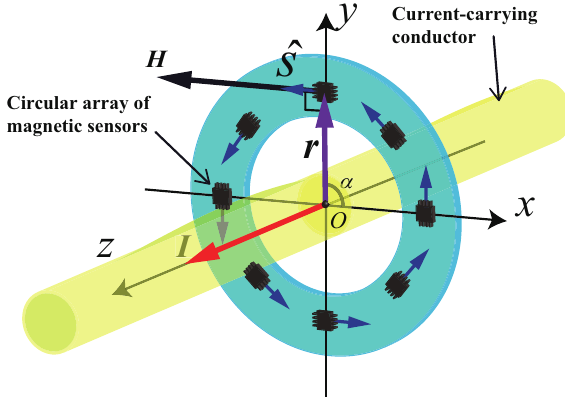
Figure 1. Basic theory of the circular array of eight magnetic